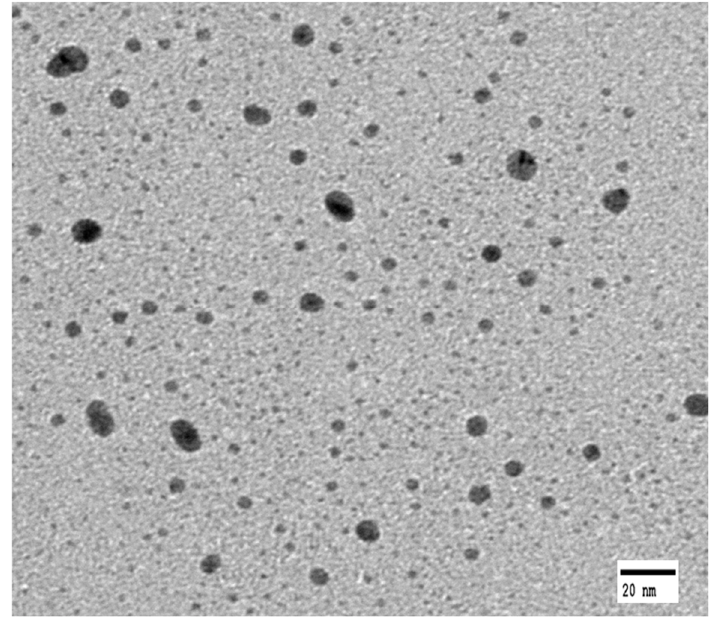
Figure 1. Transmission electron microscopy (TEM) image of AgNPs in the silver colloid solution.